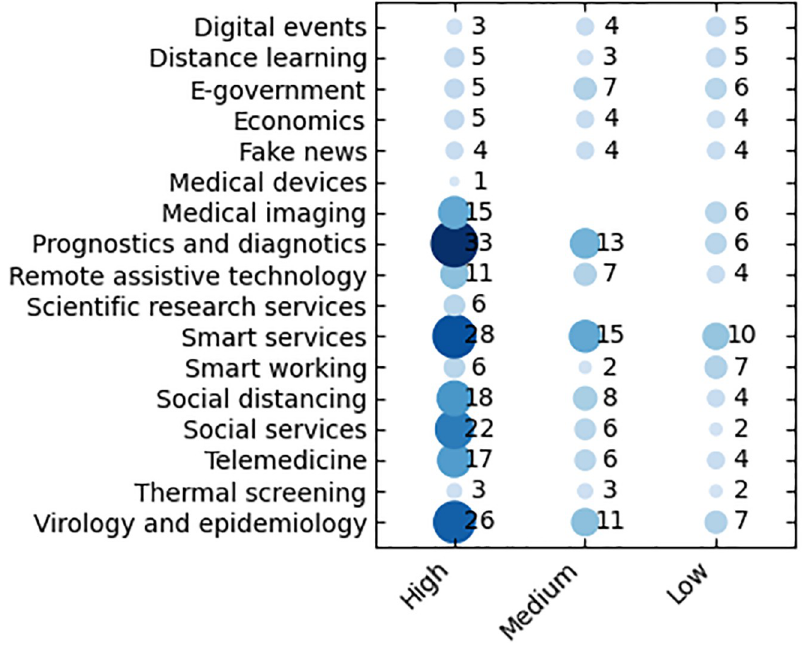
Fig 9. Number of activities per application contexts with